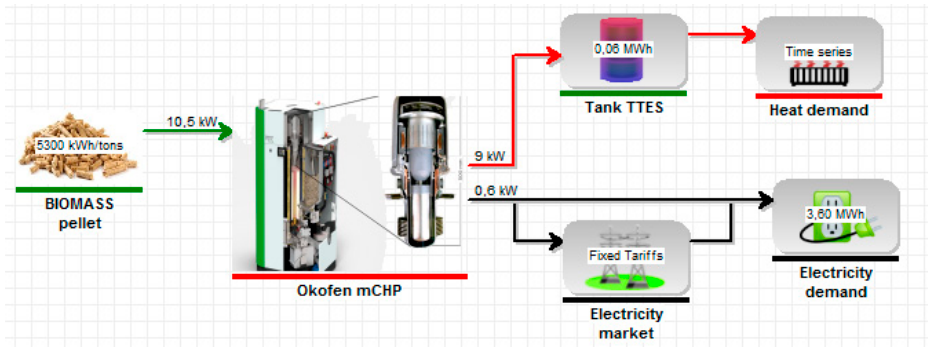
Figure 6. Scheme of the mCHP system, graphical user interface from the energyPRO 4.0 software.